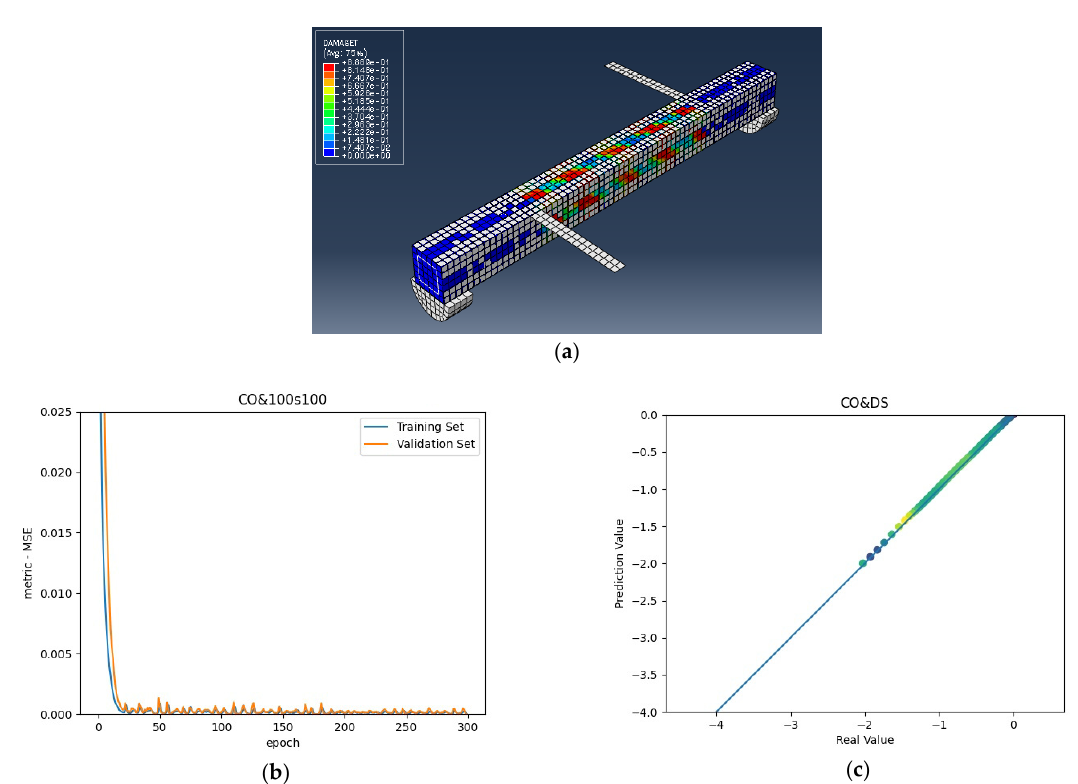
Figure 8. ( a ) 100s100 beam under combined torsion and bending, ( b ) Training loss, ( c ) Accuracy.